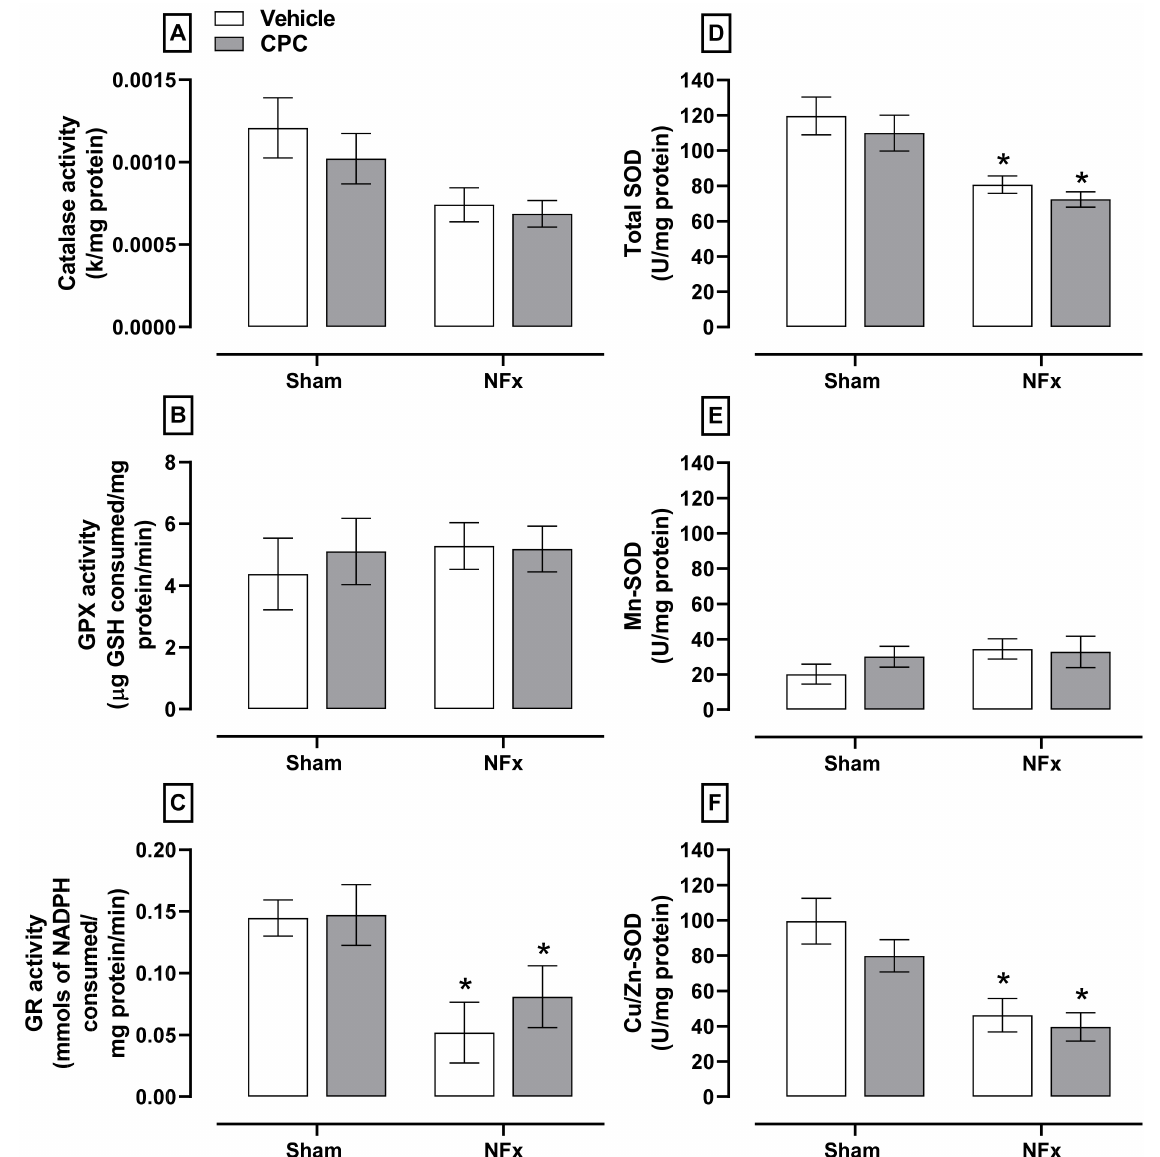
Figure 5. Effect of CPC on the activity of first-line antioxidant enzymes in aorta such as cata- lase ( A ), GPX ( B ), GR ( C ), total SOD ( D ), Mn-SOD ( E ) and Cu/Zn-SOD ( F ). Values represent the mean ± SEM. (*) p < 0.05 compared to the sham + vehicle at the same